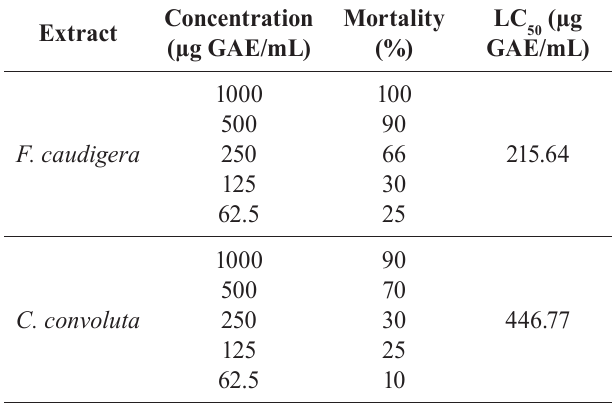
TABLE III - Brine shrimp lethality bioassay of extracts